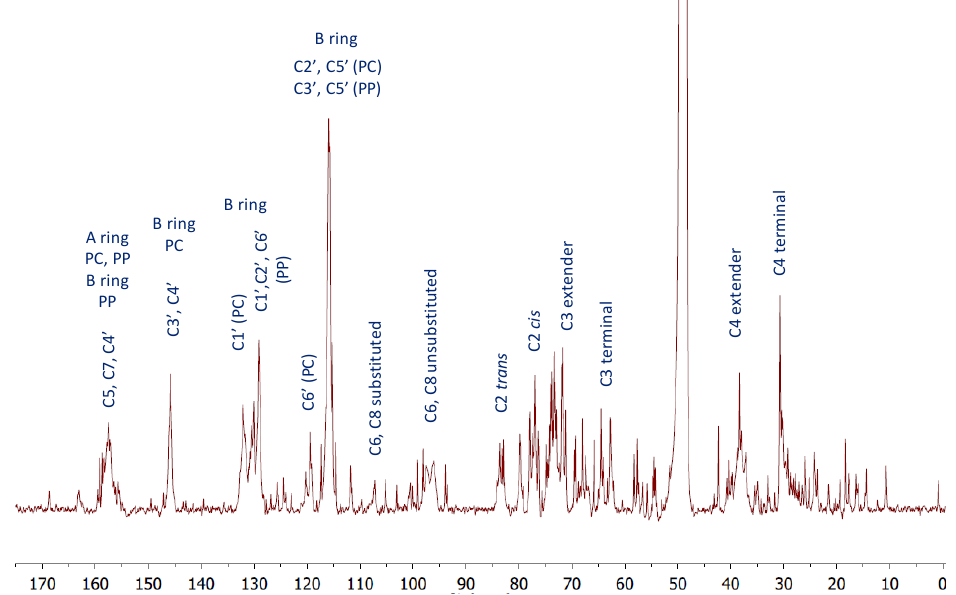
Figure 12. 13 C-NMR (MeOD) for a polyphenolic fraction of leaves (LH-F3) from U. tomentosa.